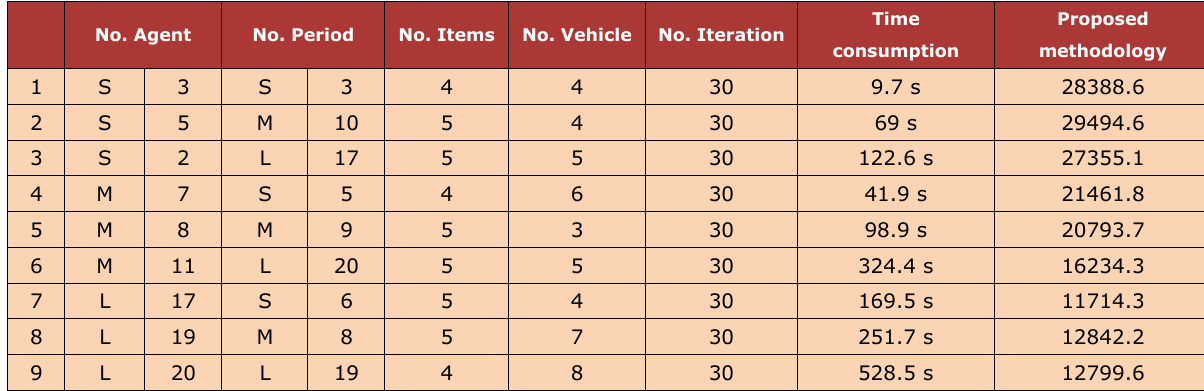
Table 3. Influence of problem dimensions on proposed methodology